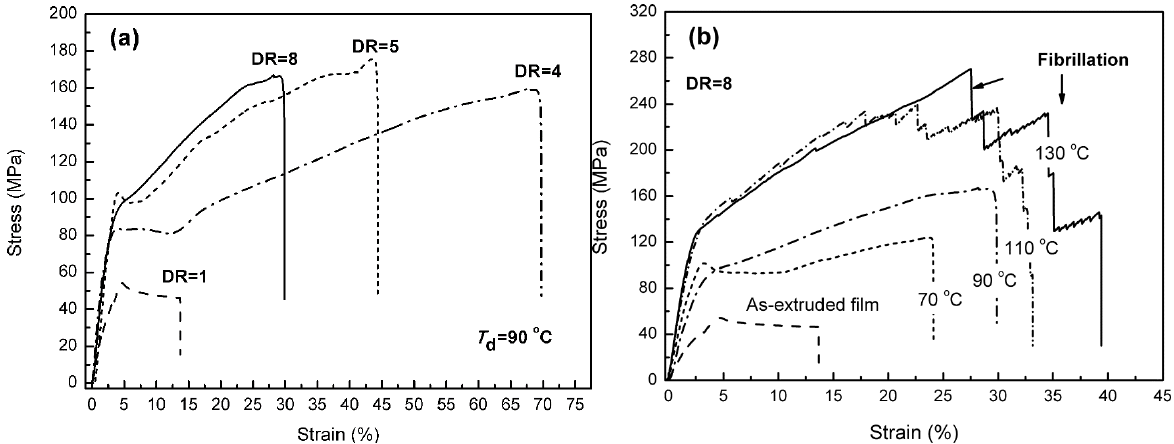
Figure 2. Stress-strain curves of poly( L -lactic acid) (PLLA) tapes subjected to ( a ) various draw ratios ( T d = 90 °C); and ( b ) different drawing temperatures ( DR =